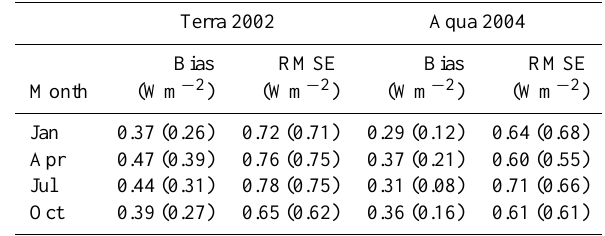
Table 1. Global mean TOA SW flux bias and RMSE by season derived from direct integration, using ADMs developed by Su et al. (2015) for the Edition 4 SSF data, and ADMs developed by Loeb et al. (2005) for the Edition 3 SSF data (shown in parentheses) for Terra 2002 and Aqua 2004.